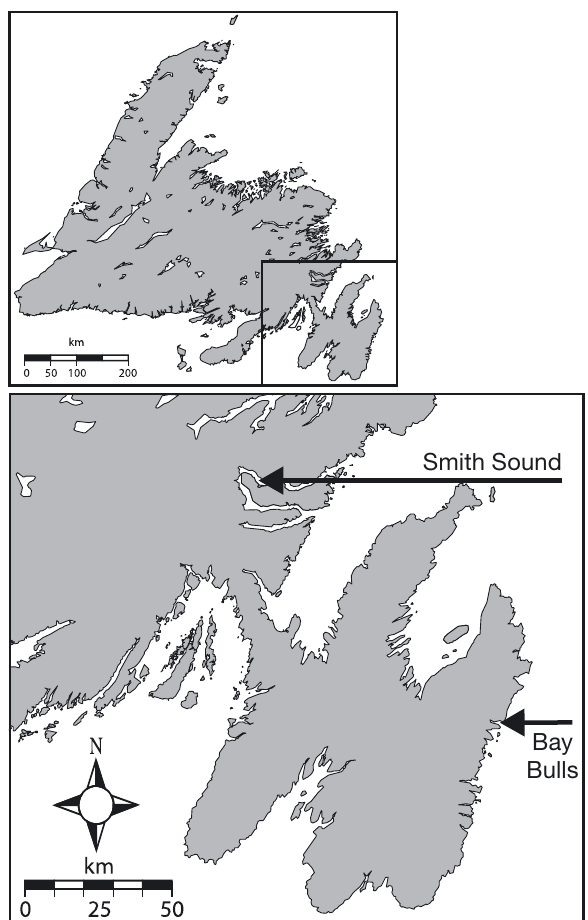
Fig. 1. Island of Newfoundland, showing the locations of sam- ple collection (Bay Bulls: 47°18’N, 52°48’W; Smith